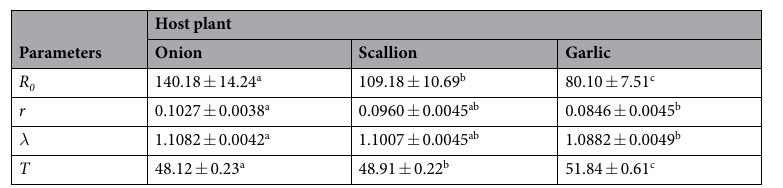
Table 2. Net reproductive rate ( R 0 ), the intrinsic rate of increase ( r ), finite rate of increase ( λ ), and generation time ( T ) of Delia antiqua on different host plant of individually reared method. The data of treatments were compared by using paired bootstrap test. Values are means ± standard errors; a,b,c Means in a row followed by different letters are significantly different at p < 0.05 by using paired bootstrap test (Table